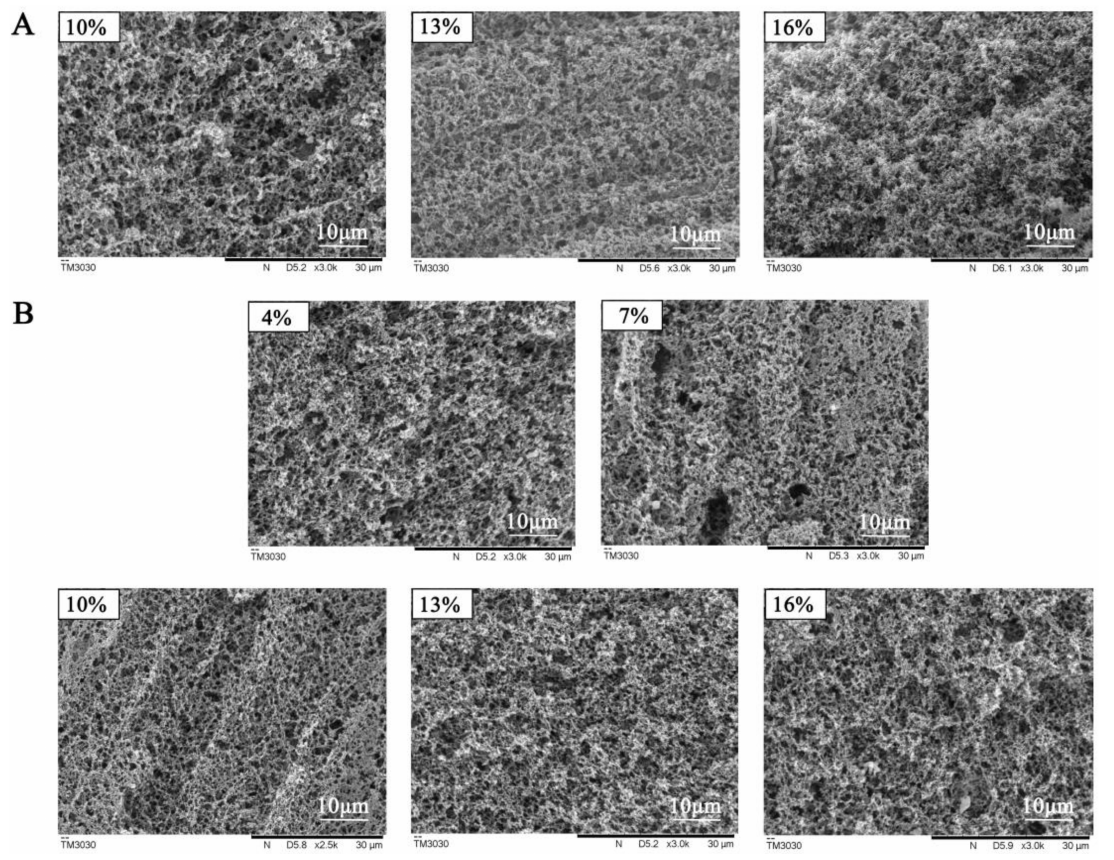
Figure 3. SEM images of tofu gelatin induced by different percentage of L. paracasei ( A ) and L. plantarum ( B ) fermented